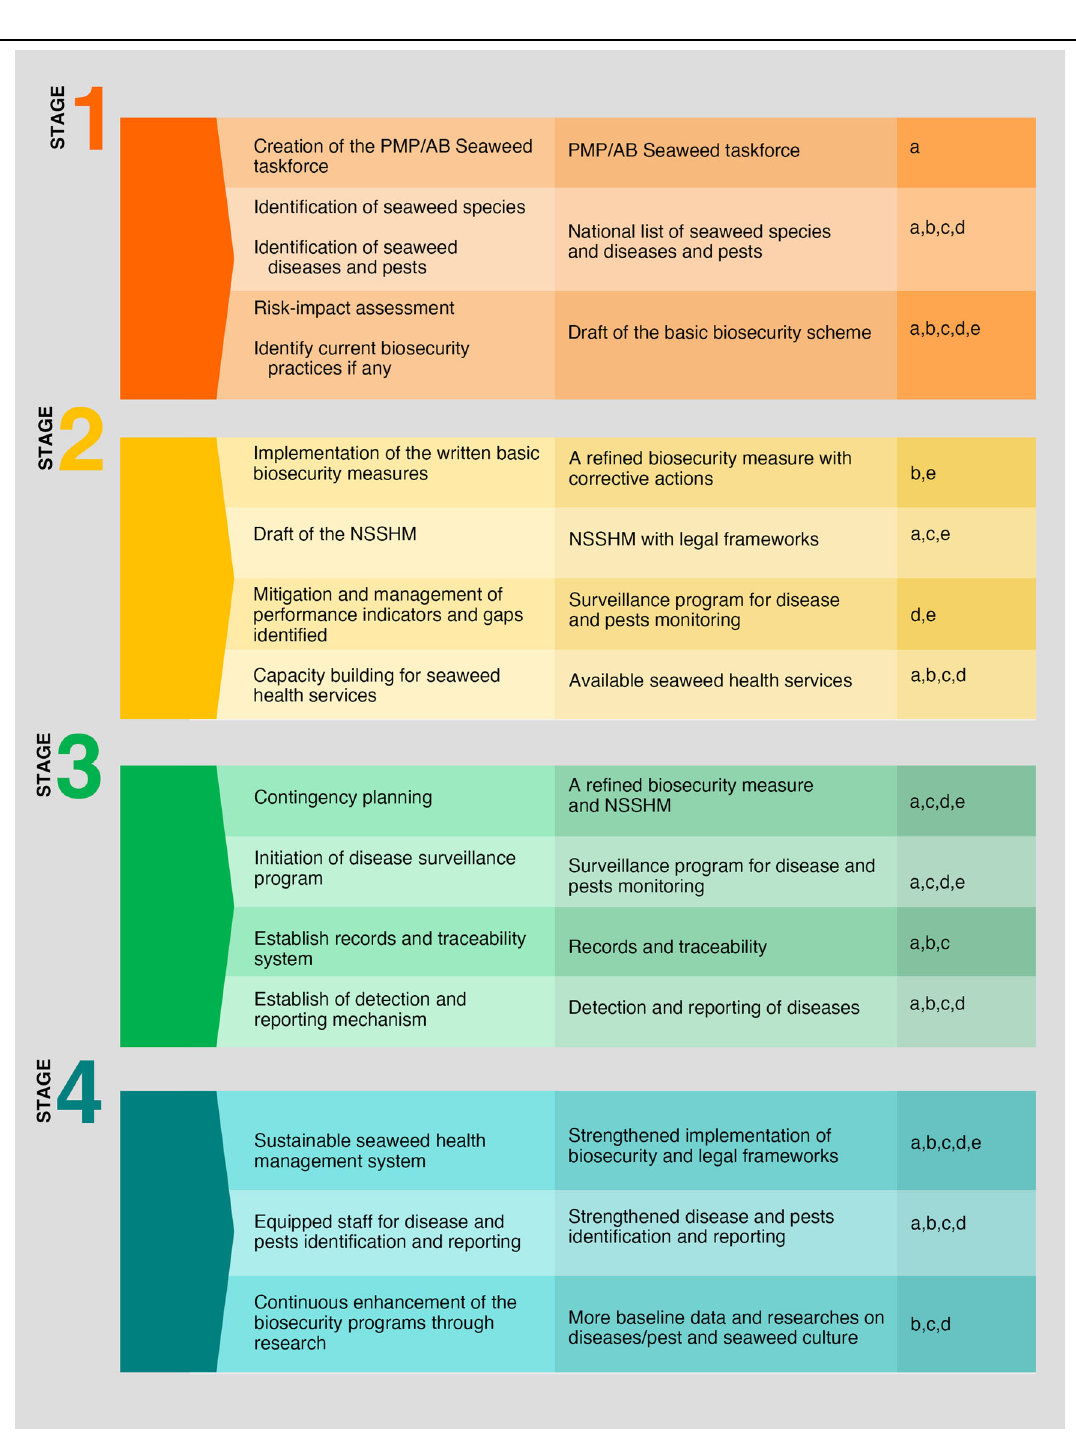
tangible outputs and constraints. (a) Technical know-how, (b) Investment capital, (c) Capacity building, (d) Innovation, (e)